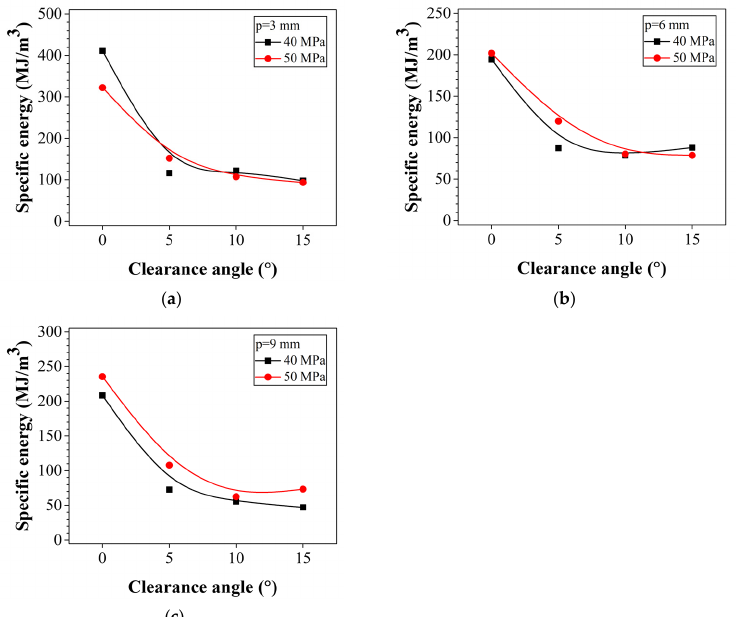
Figure 18. Relationship between the specific energy and clearance angle at depths ( p ) of: ( a ) 3 mm, ( b ) 6 mm, and ( c ) 9 mm.